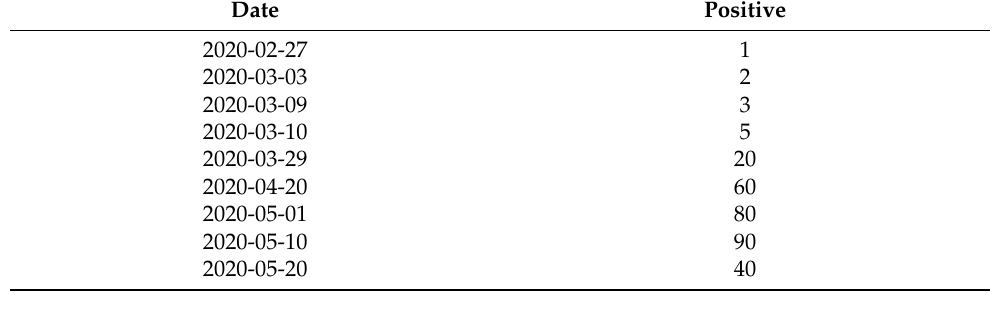
Table 2. The assumed positive cases detected over time that can result from random tests. The numbers below are only assumptions, since we do not have the official test data about positive cases found on people randomly sampled from the population.